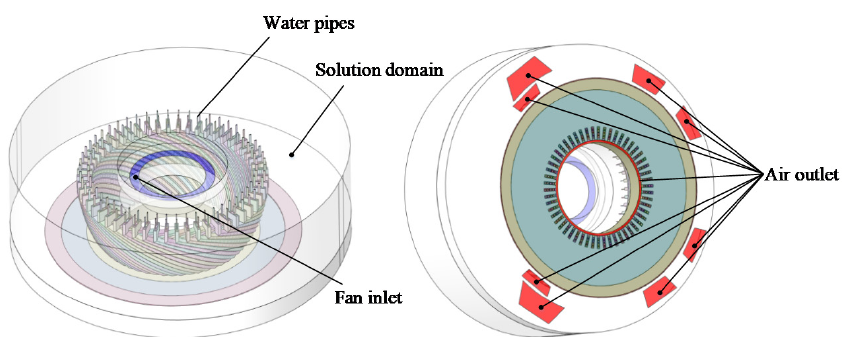
Figure 6. Flux density of the finger plate (T).